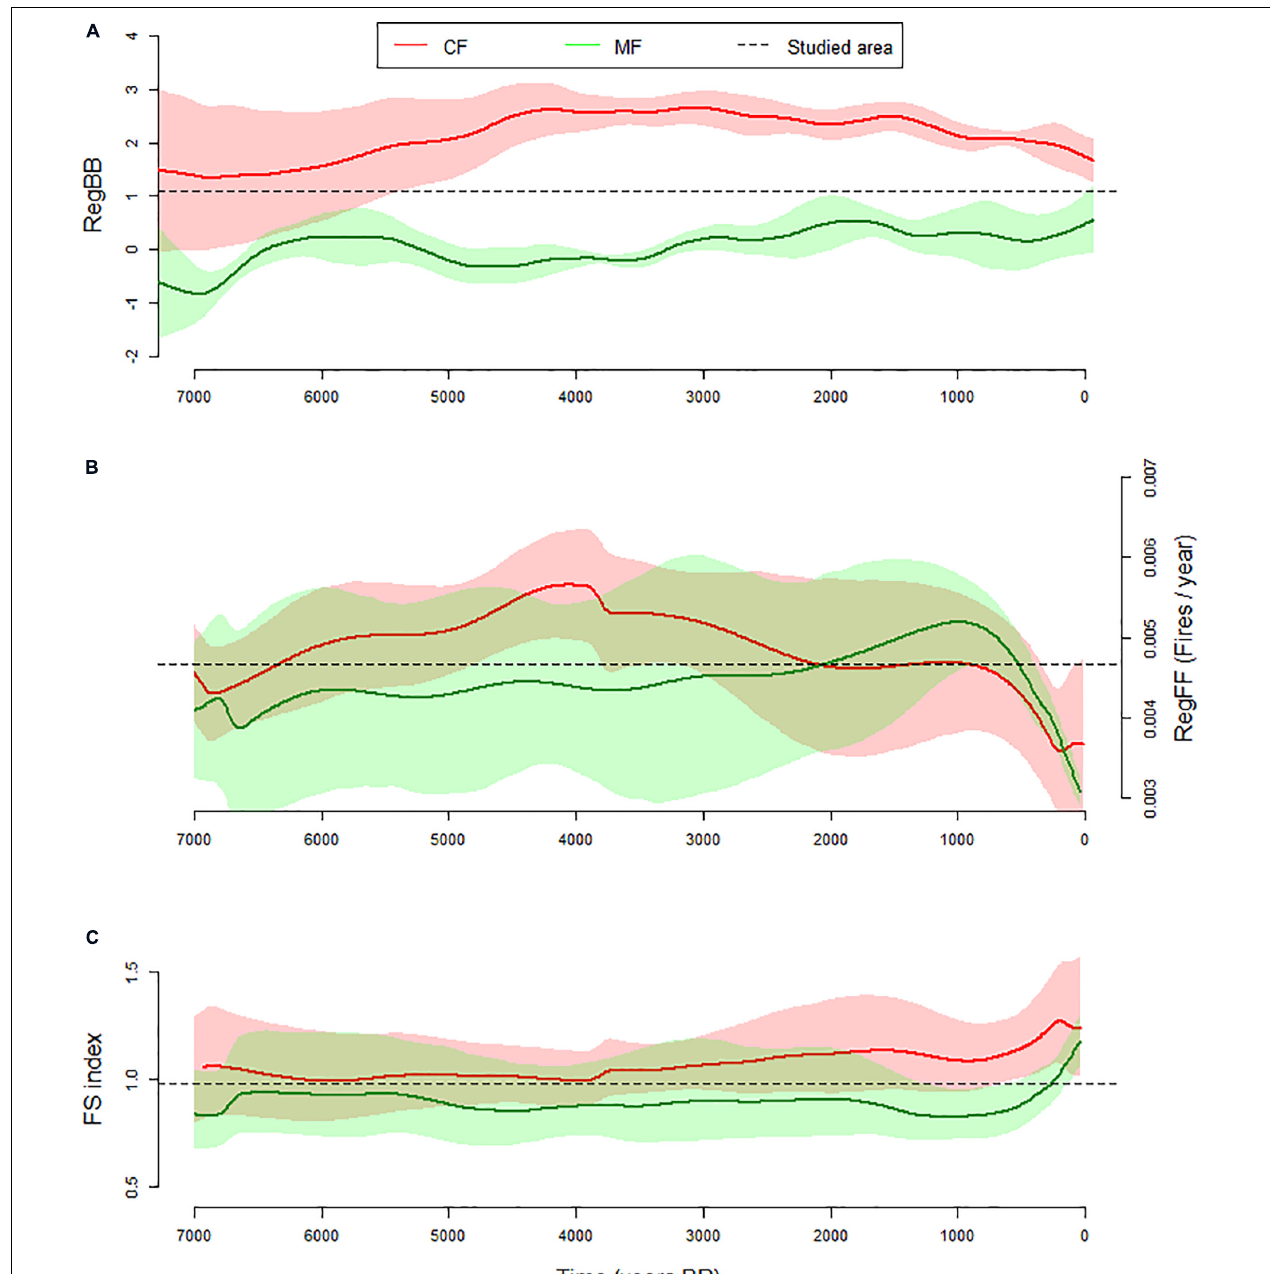
FIGURE 3 | Reconstructed Holocene fire activity changes in coniferous (CF in red) and mixedwood (MF in green) boreal forests based on lacustrine charcoals. Regional biomass burning (RegBB, A ) is unitless and refers to the average total charcoal biomass accumulated in sediments, while regional fire frequency (RegFF, B ) refers to the number of fires estimated per year using the CharAnalysis pre-treatment peak signal (Higuera et al., 2007). The Fire Size index (FS, C ) is the RegBB/RegFF ratio, which is also unitless and captures differences in the charcoal signal for periods when fires were frequent but rather small (FS < 1) versus rare but rather large (FS > 1, Ali et al., 2012). In each panel, the overall regional signal including all lacustrine cores from both forest types is indicated by a dashed line, and for each forest type the envelop represents the 95% Bootstrap Confidence Intervals (BCI) computed using the 2.5% and 97.5%